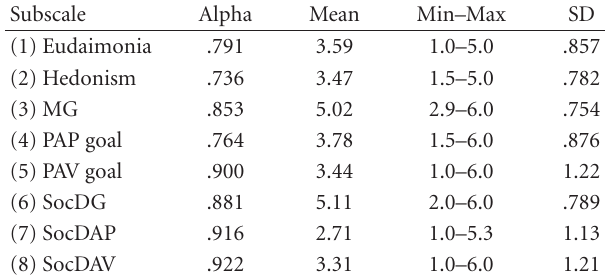
Table 2: Descriptive statistics for all scales and subscales.